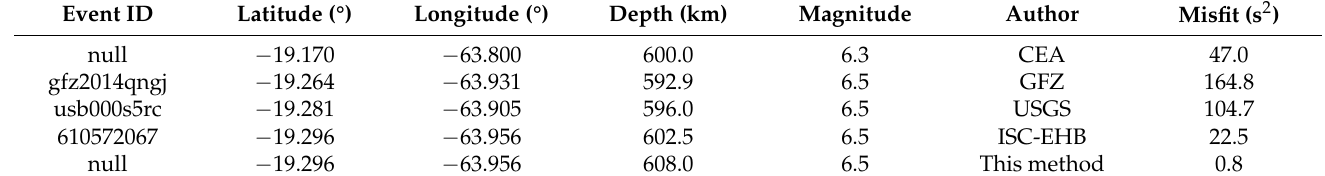
Table 2. The result and comparison for the deep event occurred on 02/21/2017, Mw 6.1, Bolivia.